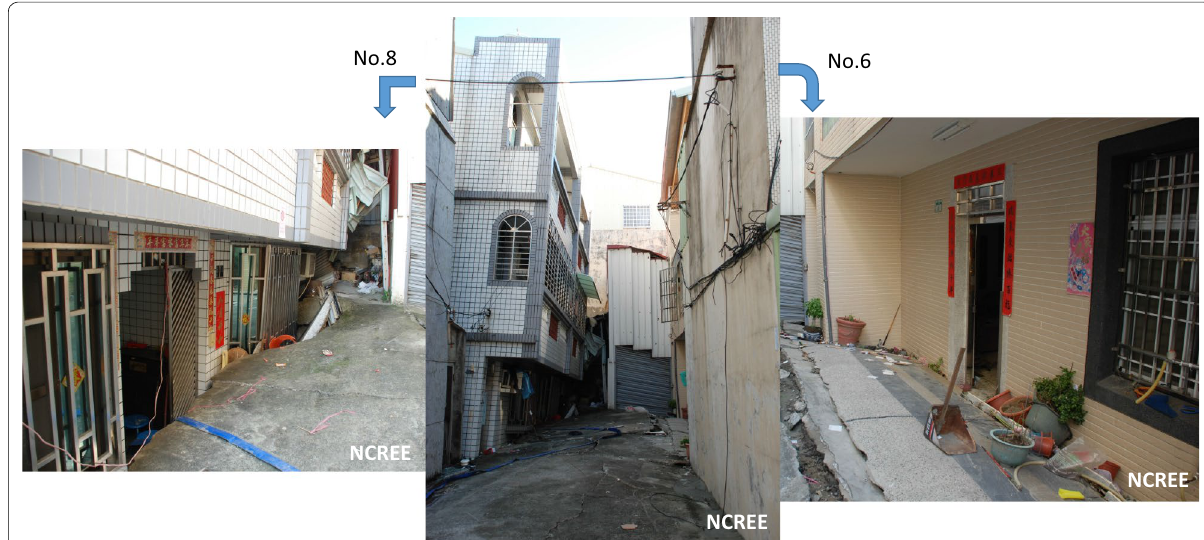
Fig. 3 Damages to No. 8 and 6 three‑story buildings at Lane 161, Huian Street (Annan District)